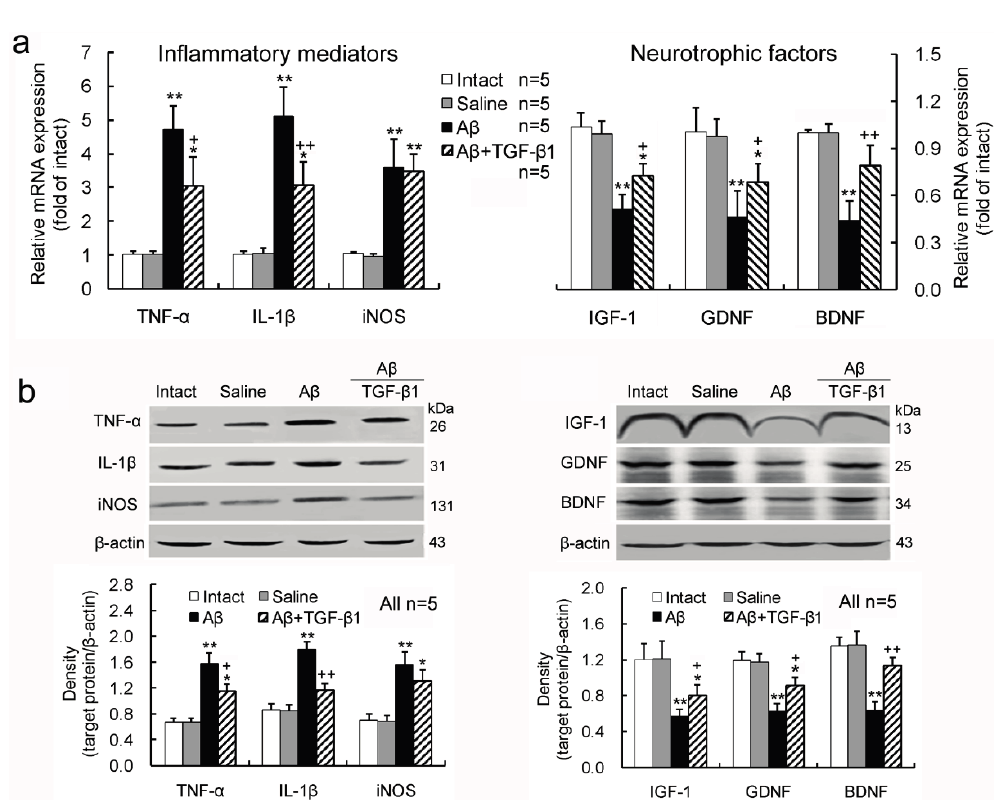
Figure 2. TGF- β 1 reduces A β 1–42 -induced upregulation of inflammatory mediators and down-regulation of neurotrophic factors in the hypothalamus. TGF- β 1 (50 ng/5 μ L) was administered via ICV seven days after A β 1–42 injection, and on Day 3 following the TGF- β 1 administration, the expression levels of mRNAs ( a ) and proteins ( b ) for the inflammatory mediators and neurotrophic factors in the hippocampus were determined. * p < 0.05, ** p < 0.01, versus intact or saline injection; + p < 0.05, ++ p < 0.01, versus A β 1–42 treatment